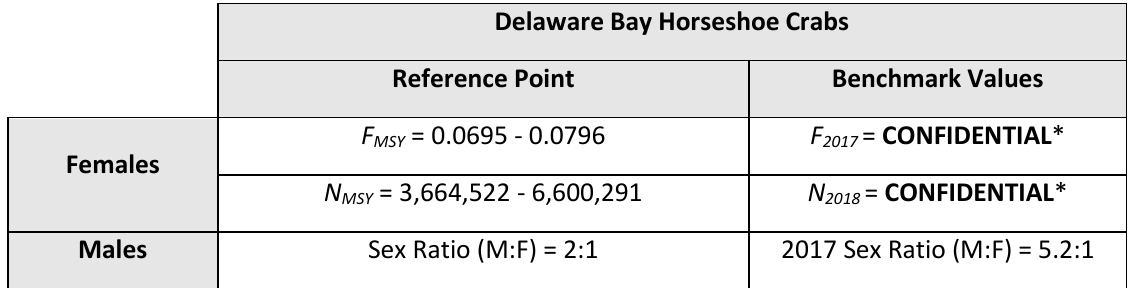
Table 52. Sex specific fishing mortality ( F ) and biomass reference points for the Delaware Bay region generated from a population projection model (Table 50) along with terminal year values from the base run of the catch survey model.